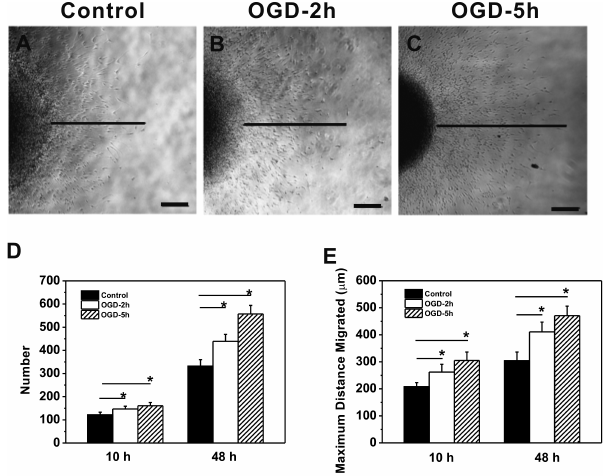
Figure 5. NSC migration under OGD treatment. (A-C) The representative images of the migrated cell from the neurospheres for 48 h in control, OGD-2 h and OGD-5 h groups, respectively. Scale bar = 100 µm. The inset lines indicate the maximum length of the cells migrated from the neurospheres in the three groups. (D) Numbers of the migrated cells from the neurospheres. (E) Mean maximal distance migrated from the neurospheres for 10 h and 48 h. Data were presented as mean ± S.E.M. *p < 0.05 vs